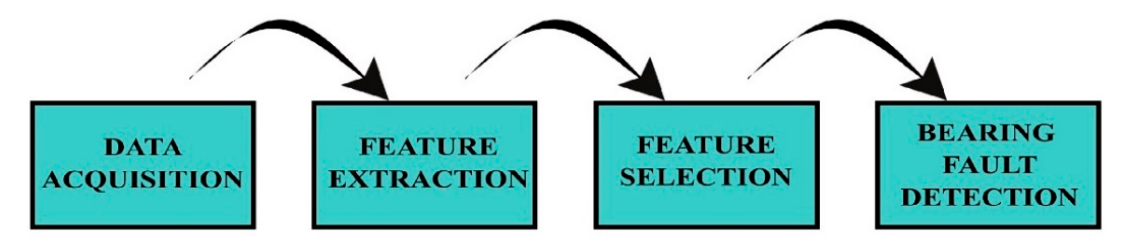
Figure 3. Generic steps of a data-driven fault diagnosis methodology.